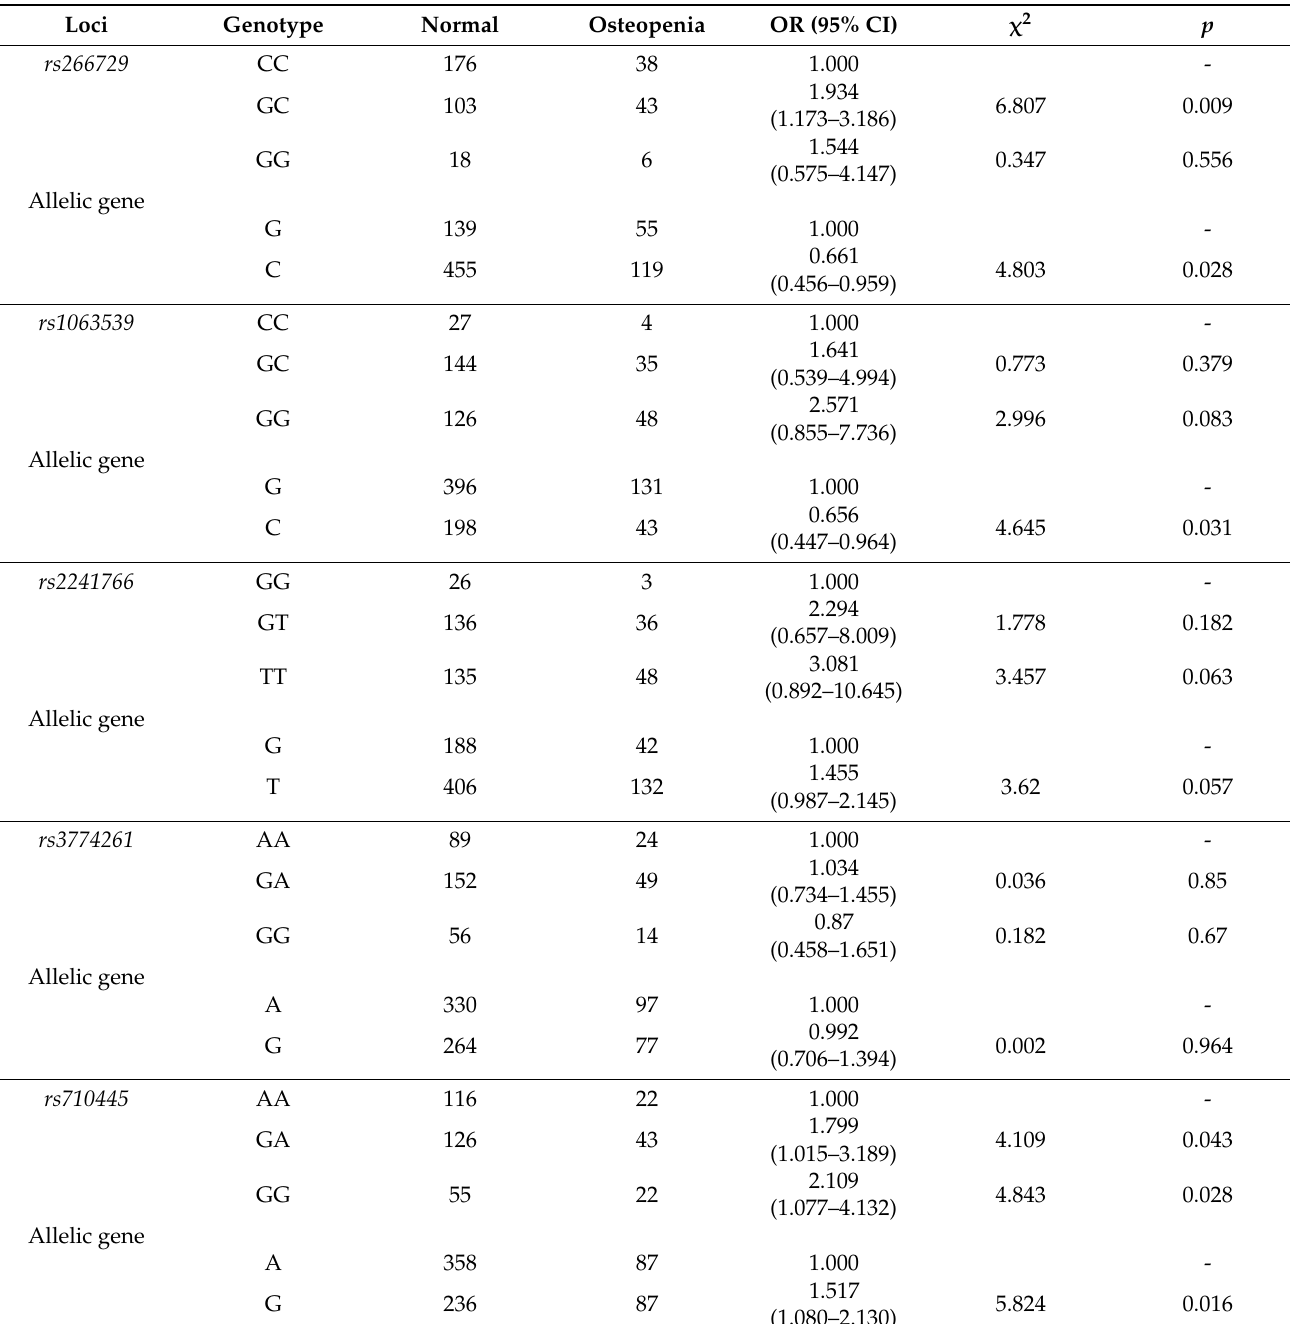
Table 4. Genotype and allelic gene frequency distribution in five SNPs of